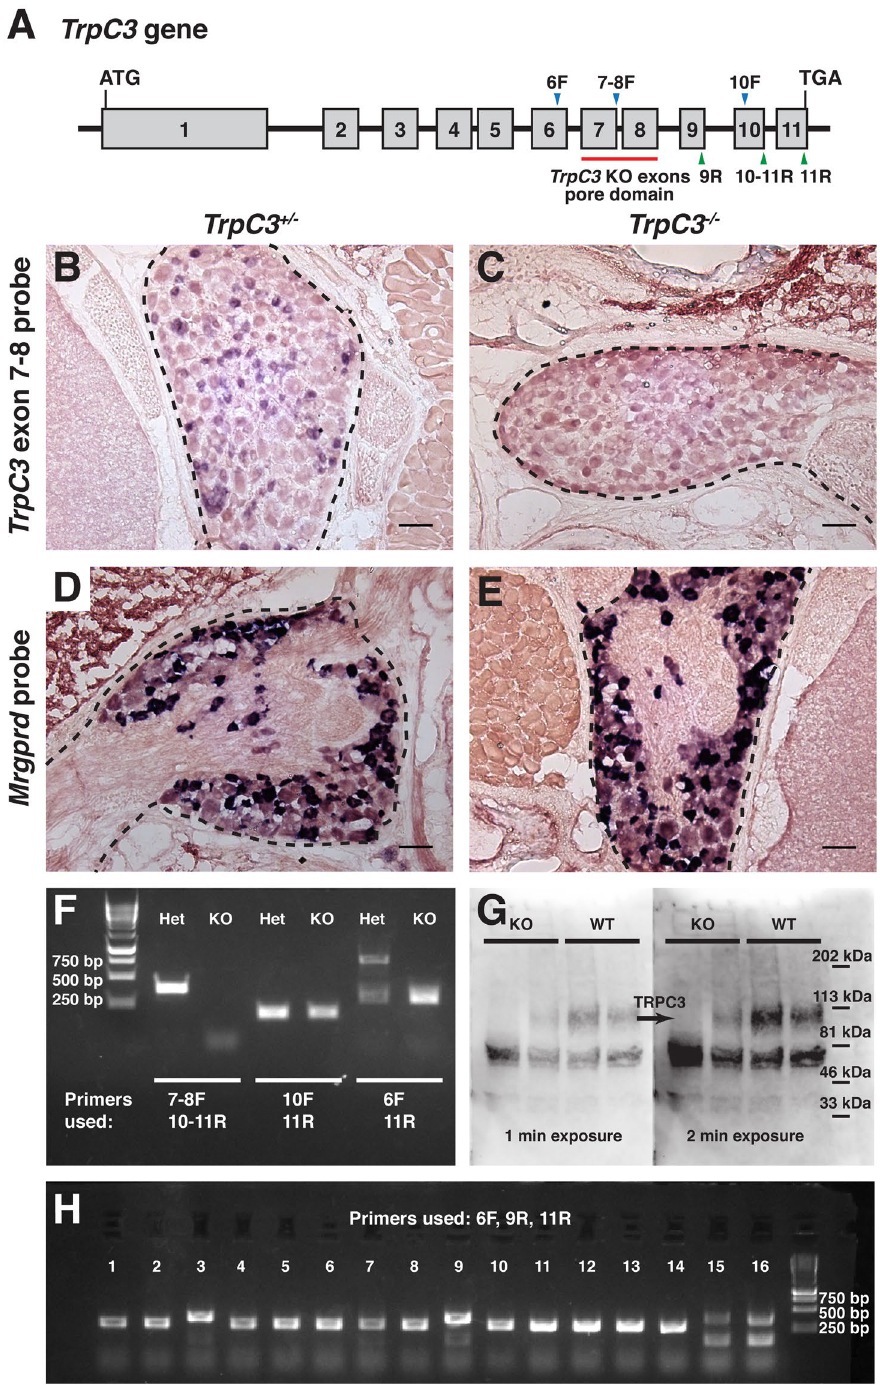
Figure 4. Characterization of the TrpC3 knockout mice. ( A ) Diagram of the TrpC3 gene, depicting the 11 exons, of which 7–8 are excised in the KO. Also shown are the primers used in RT-PCR and colony PCR experiments, which include forward primers recognizing exon 6, the junction of exons 7–8, and exon 10 (6 F, 7–8 F, 10 F) and reverse primers recognizing exons 9, 11, and the junction of exons 10–11 (9 R, 11 R, 10–11 R). ( B and C ) AP colorimetric in situ hybridization with a TrpC3 probe that recognizes exons 7 and 8 of TrpC3 transcript in TrpC3 heterozygote and KO mouse DRG thoracic sections. Probe signal is seen in the TrpC3 heterozygote DRG but not in the KO. ( D and E ) AP colorimetric in situ hybridization with an Mrgprd probe in TrpC3 heterozygote and KO mouse DRG thoracic sections. No obvious difference in signal is seen between the TrpC3 heterozygote and KO. For panel 4B–E, DRG is outlined by the dashed black line. Scale bars = 50 μ m. ( F ) RT-PCR performed on RNA acutely isolated from TrpC3 heterozygote and KO DRG neurons. cDNA was amplified with primers specific for (from left to right): forward primer at the junction of exons 7–8 and reverse primer at the junction of exons 10–11 (WT: 387 bp, KO: no band), forward and reverse primers specific